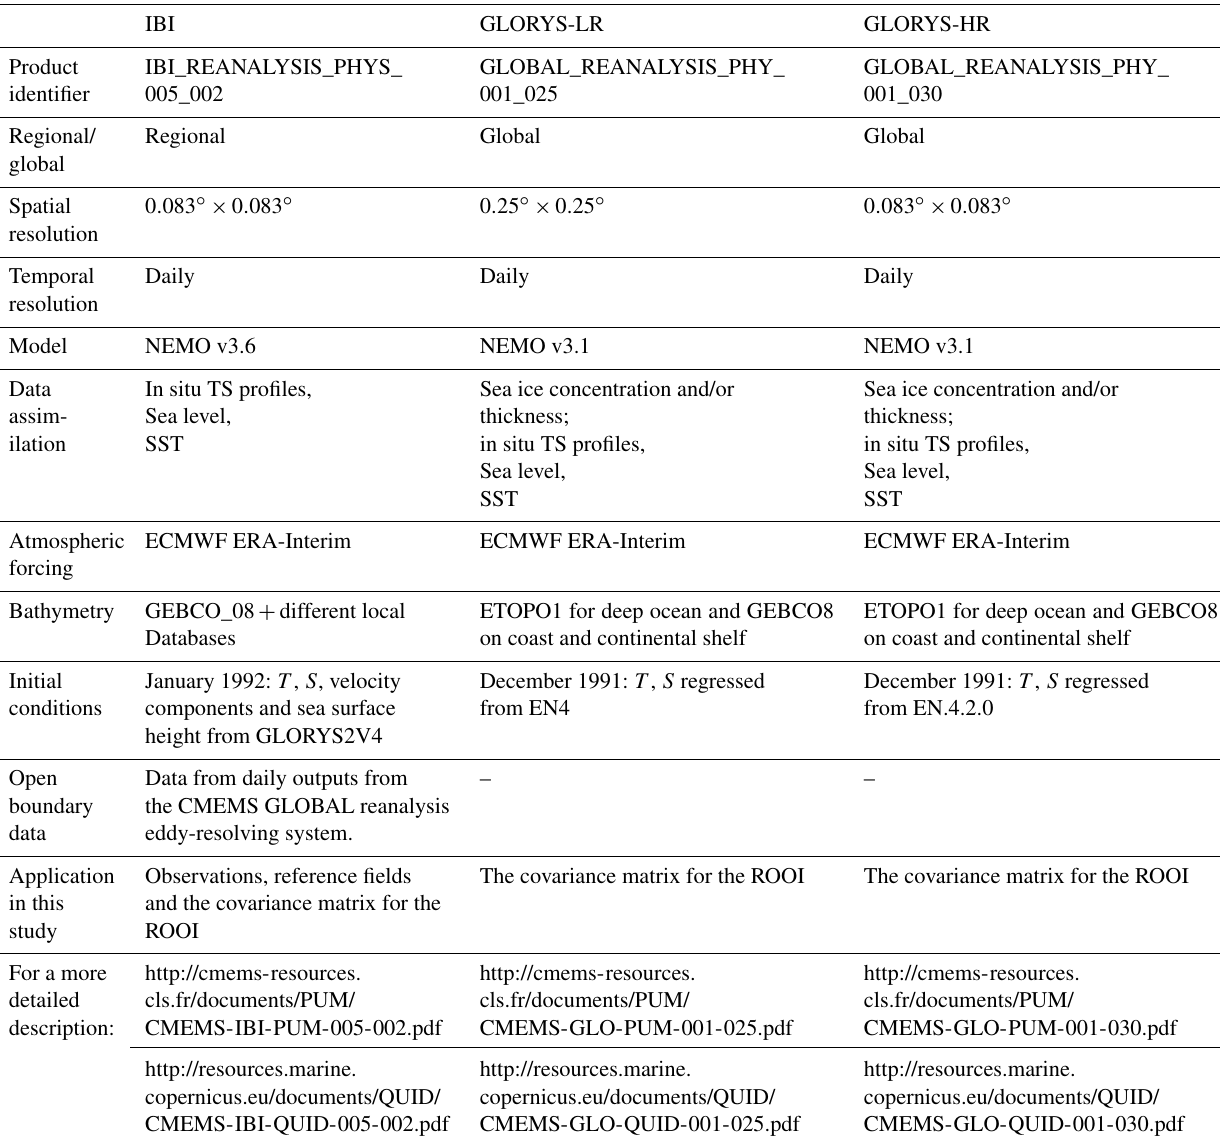
Table 1. Details of the numerical simulations used in this study. Note that TS represents temperature salinity. (All URLs in this table were last accessed on 16 April 2020.)